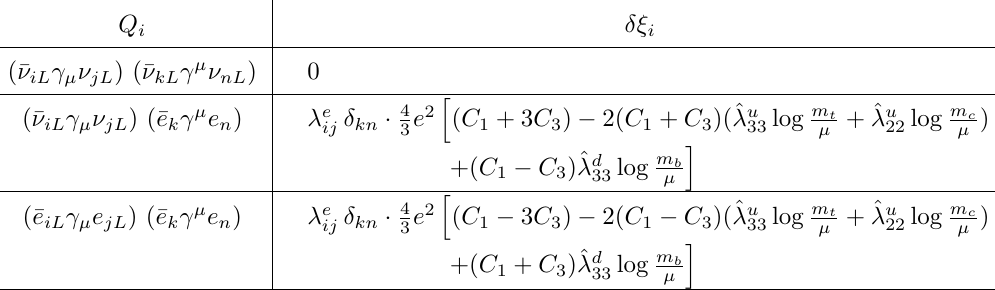
Table 6 . Operators Q i and coe(cid:14)cients (cid:14)(cid:24) i for the purely leptonic part of the e(cid:11)ective Lagrangian (cid:14) L QED . We set ^ (cid:21) u;d = (cid:21) u;d = log m EW . ii ii e(cid:11) (cid:22) Q i (cid:14)(cid:24) i